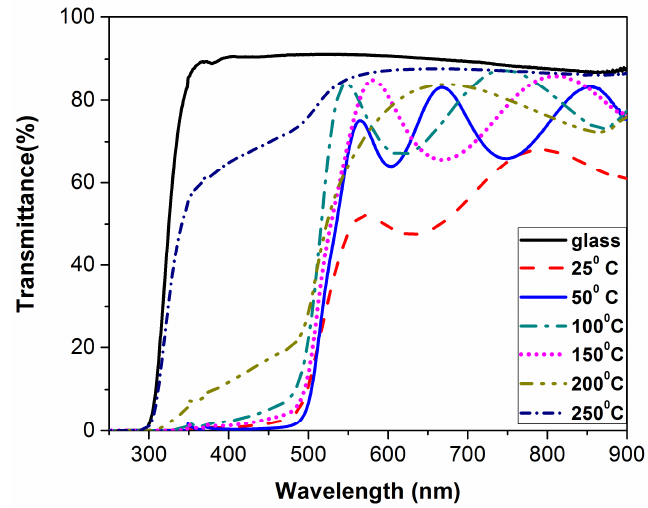
Table 2. Electrical parameters of CdS thin films. t: film thickness; R sh : sheet resistance; ρ : resistivity.